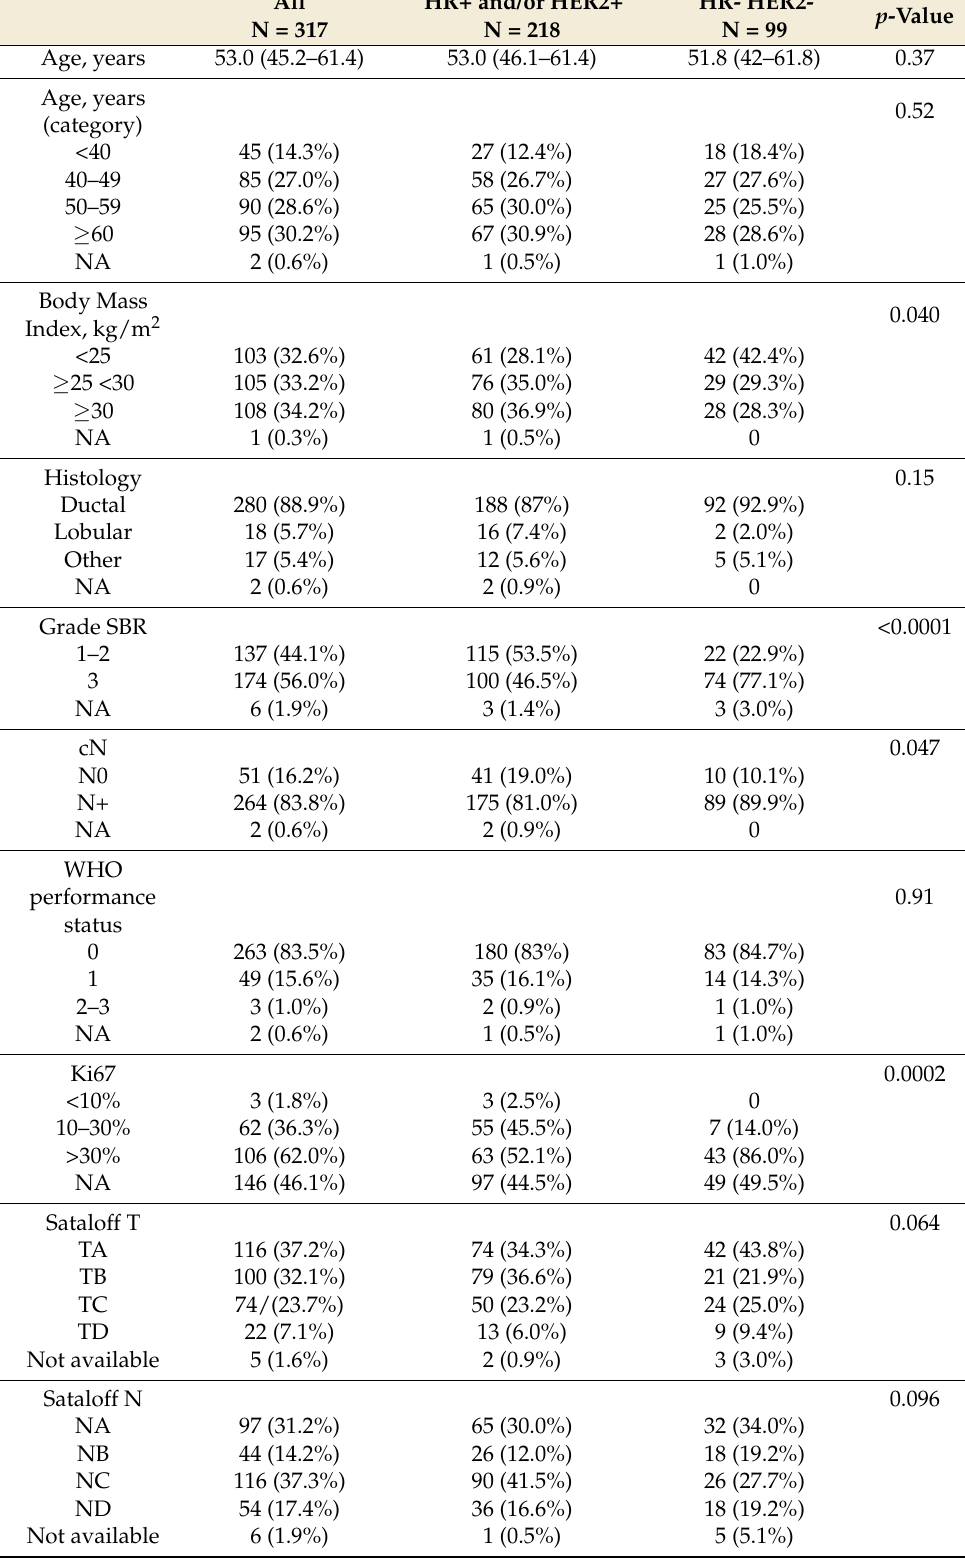
Table 1. Baseline demographics, clinical characteristics, and response after neoadjuvant